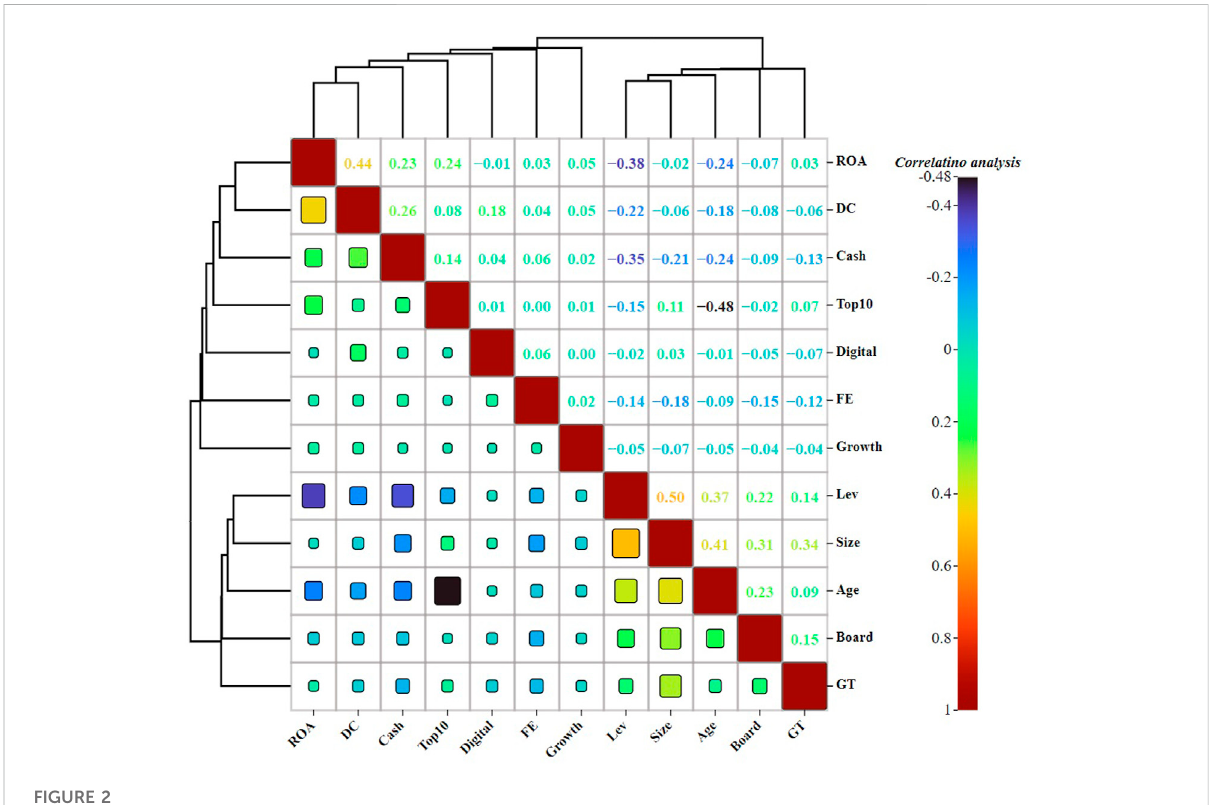
FIGURE 2 Correlation clustering heat